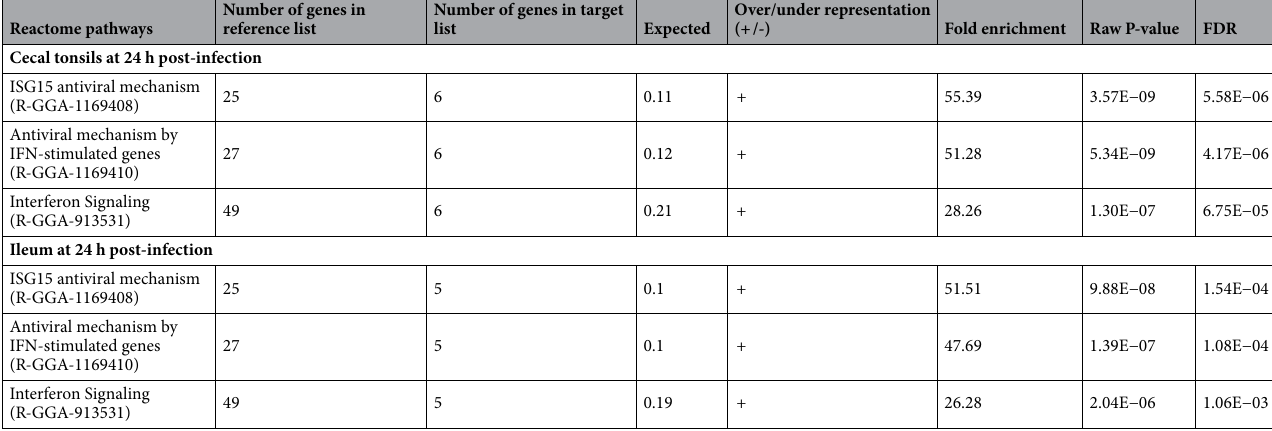
Table 2. Functional annotation analysis of Reactome pathways using PANTHER. Overrepresentation analysis was performed on PANTHER. The analysis was performed on upregulated genes of significant gene changes in each tissue at each time point by filtering genes with a fold change of + /− 1.5 and significant P -value of False Discovery Rate (FDR) controlled at 5%. IFN interferon, ISG IFN-stimulated